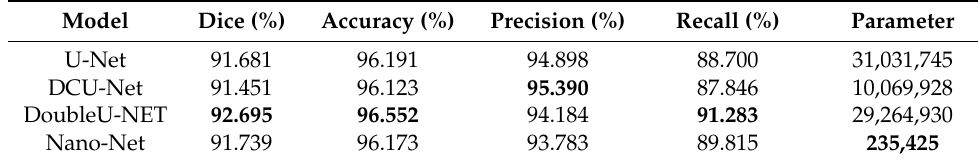
Table 4. Segmentation models without augmentation data.